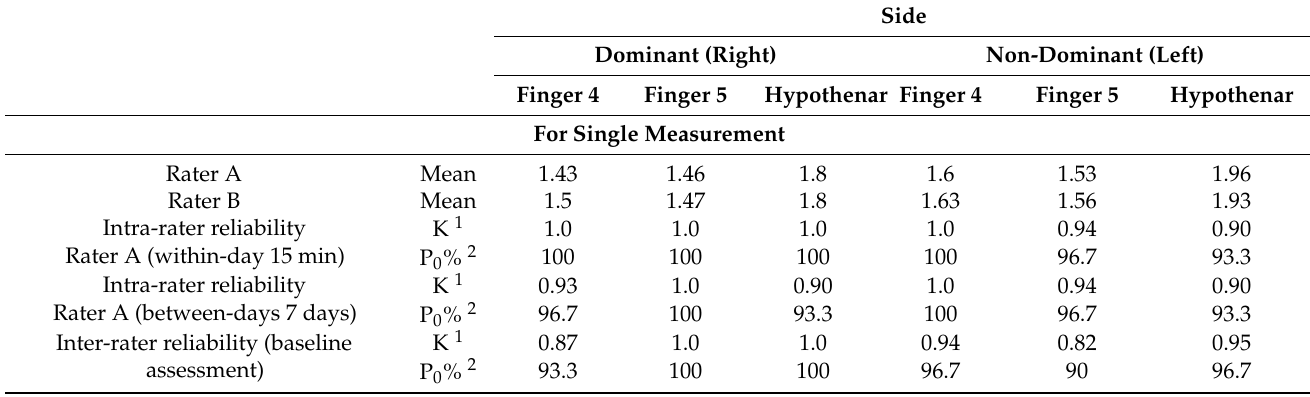
Table 3. Reliability and validity Semmes–Weinstein monofilament (SWM) test—healthy volunteers (n =